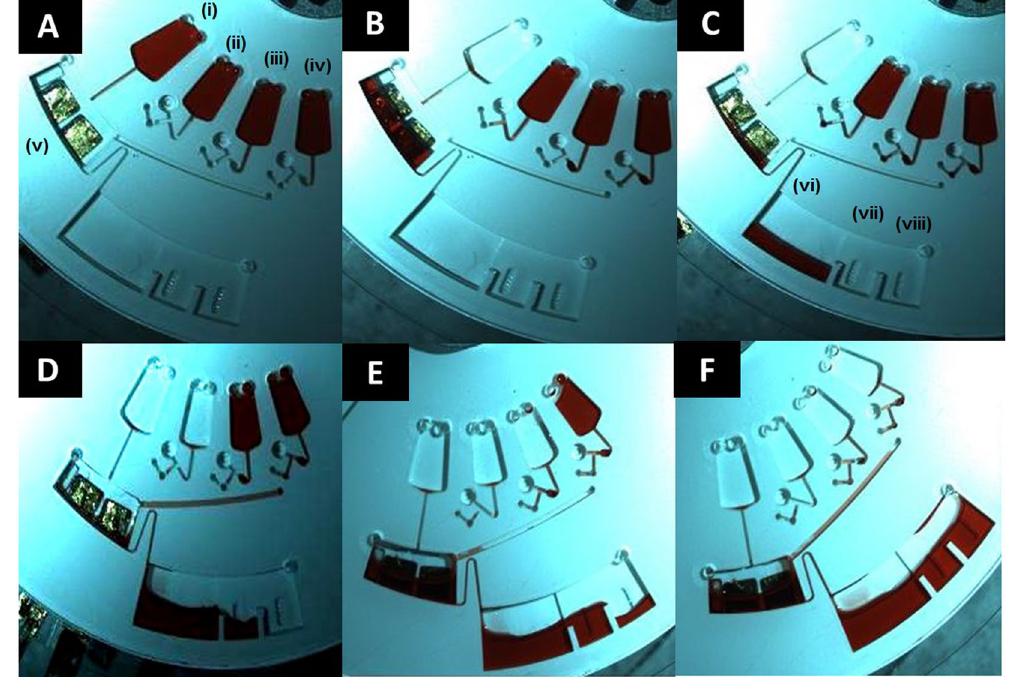
Figure 2. Stepwise display of the triggering system implemented to allow complete functionalisation of the working electrode with the sandwich assay in the incubation chamber of the microfluidic device. Each image is cropped to show just one section of the disc. Red food dye is preloaded into the chambers instead of samples for visualisation purposes only. Chambers (i–iv) are the preloaded sample chambers. Chamber (v) is the electrode chamber. Chamber (vi) is the waste chamber, with (vii) and (viii) as the overflow of the